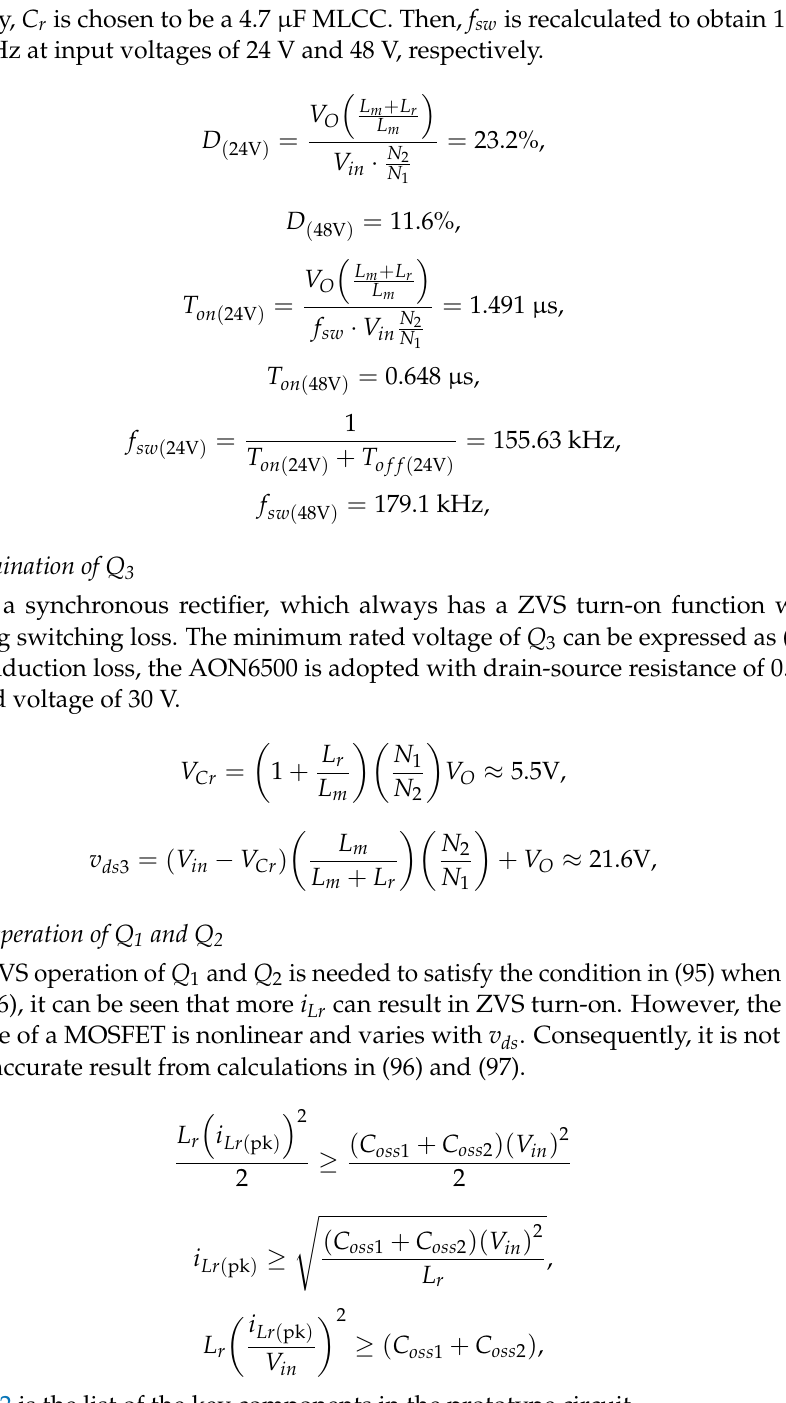
Table 2 is the list of the key components in the prototype